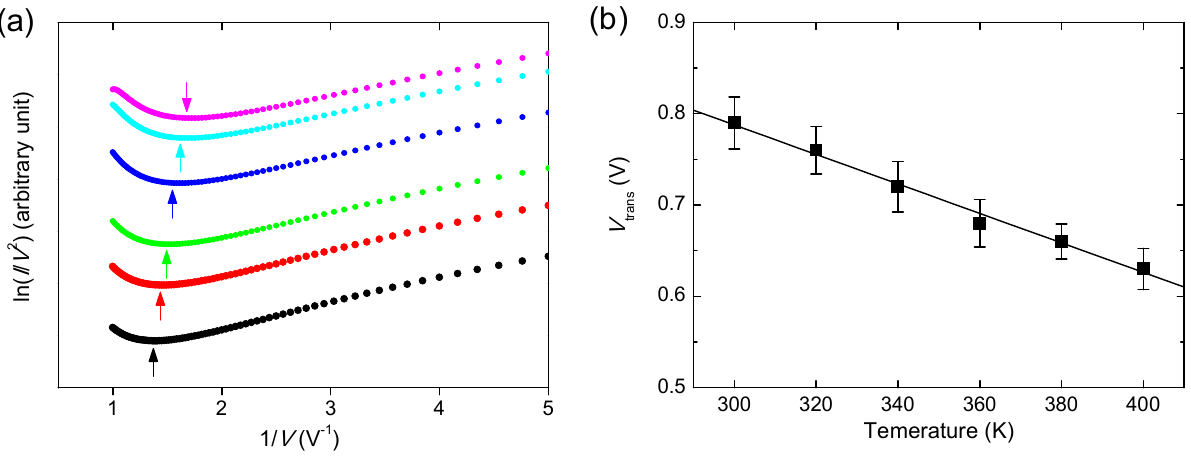
Figure 5. ( a ) Fowler–Nordheim plots of OPD- n junctions. Arrows indicate V trans . ( b ) Plot of V trans versus temperature. Solid line indicates a linear fit and error bars denote a standard deviation.